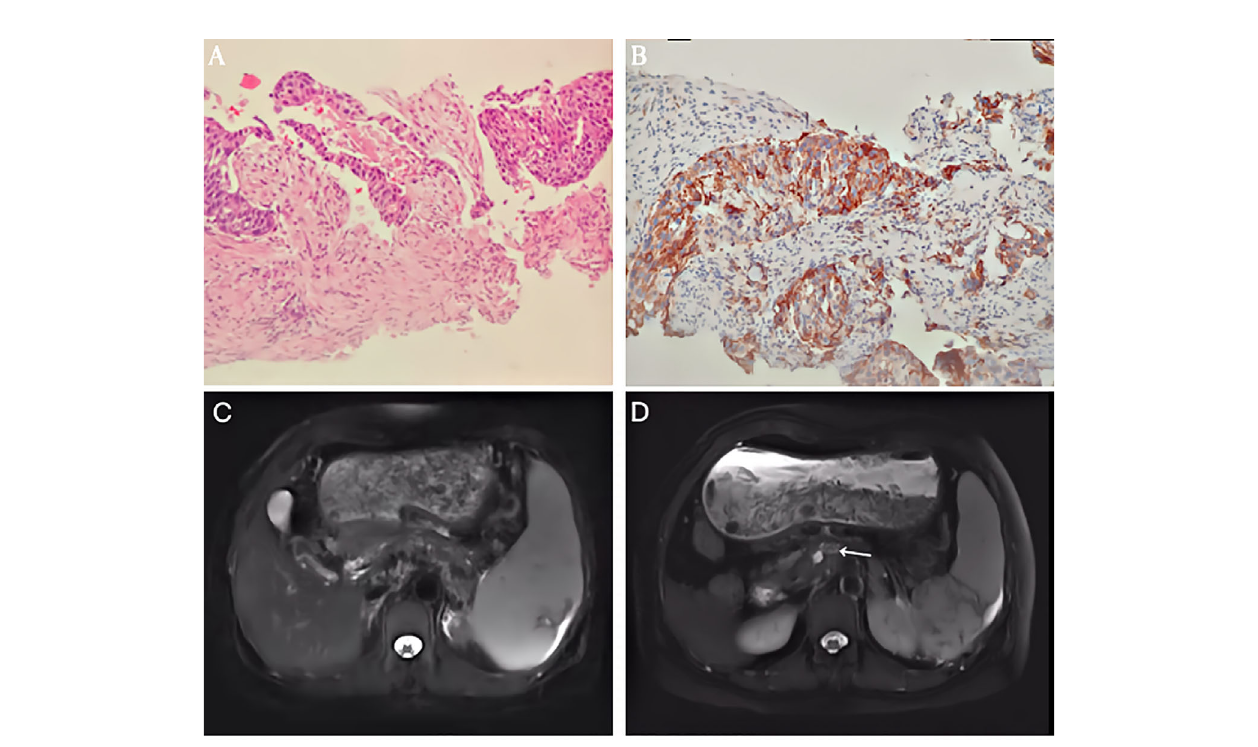
FIGURE 3 | (A) Histological fi ndings revealed a pancreatic squamous cell carcinoma (SCC) with abundant eosinophilic cytoplasm and large vesicular nucleus. (HE x 200). (B) Immunohistochemical staining of PD-L1 expression. Original magni fi cation, x200. (C) T2-weighted magnetic resonance imaging (MRI) showed the mass decreased to 55 mm in the maximum diameter. (D) T2-weighted magnetic resonance imaging (MRI) showed the mass measured 16mm after 2 cycles of intra- arterial